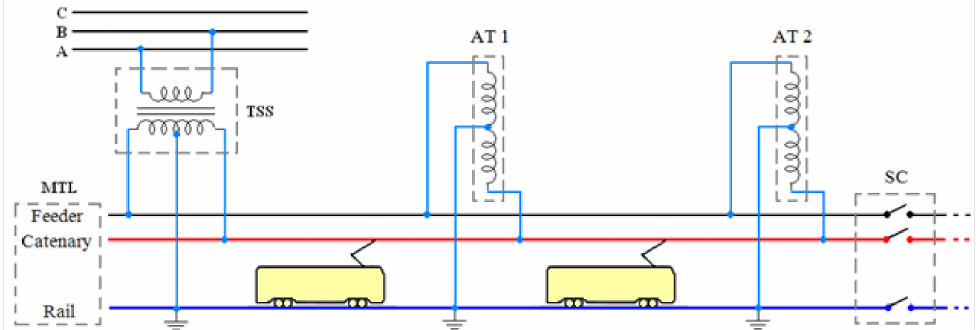
Figure 1. General configuration of the traction